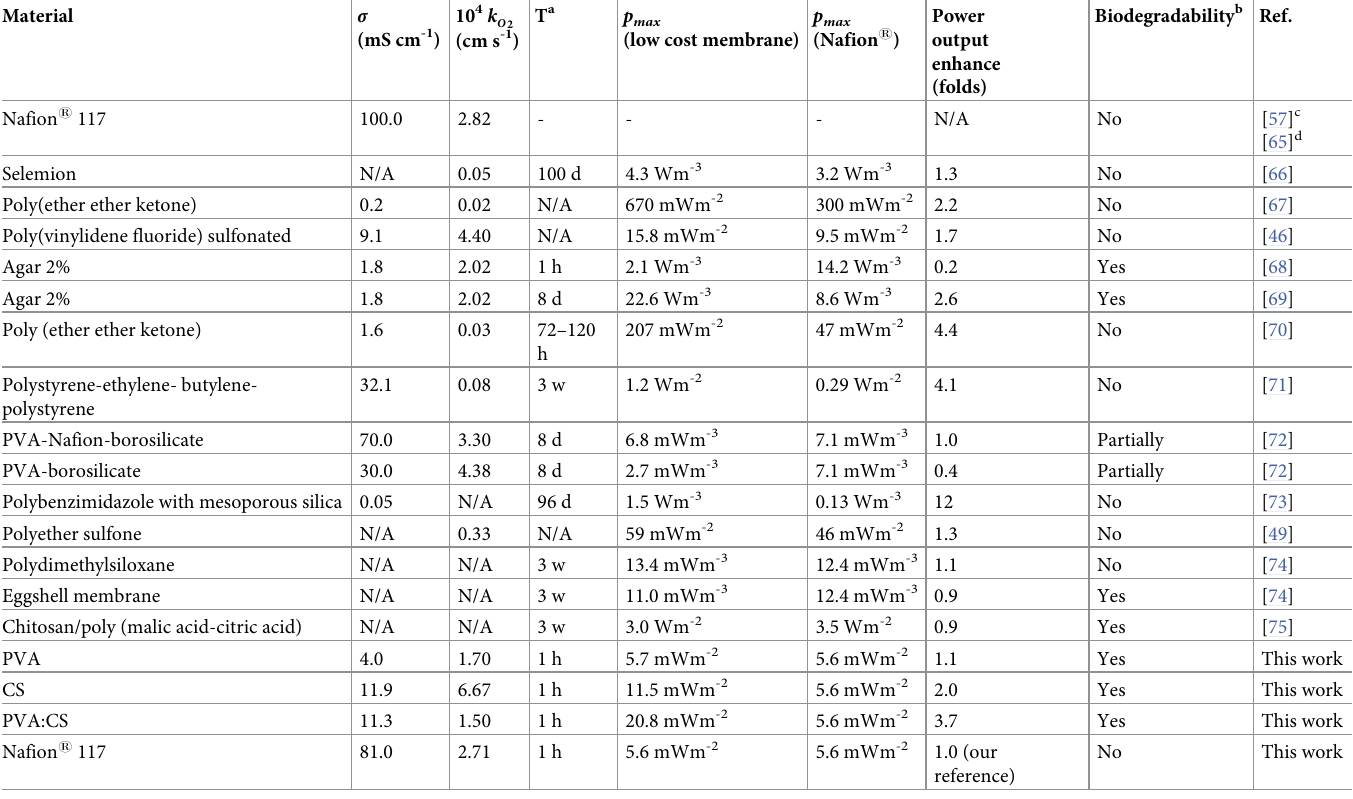
Table 3. General features of low-cost membranes and biodegradability comparisons. Nafion 1 is used as reference membrane, first line shows data provide by Dupont, last line our experimental data. Material